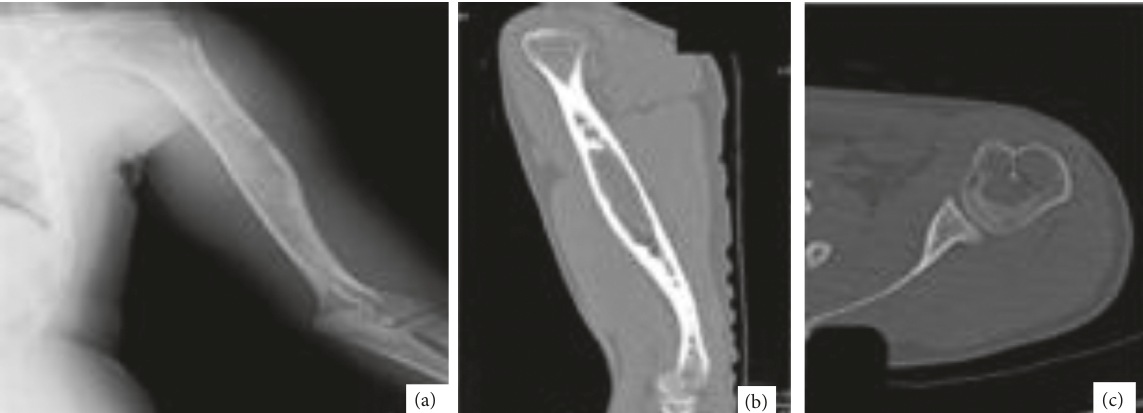
Figure 6: (a) AP X-ray of the humerus showing cystic lesions involving the proximal and midhumerus. (b, c) Sagittal and axial CTfor the same patient showing expansile cysts of the mid and proximal humerus, respectively.